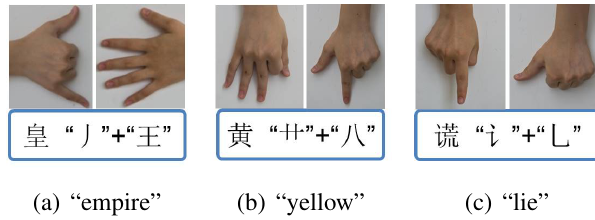
Figure 5. Component-coded gestures of characters sharing the same pronunciation “huang”. ( a ) Chinese character “empire”; ( b ) Chinese character “yellow”; ( c ) Chinese character